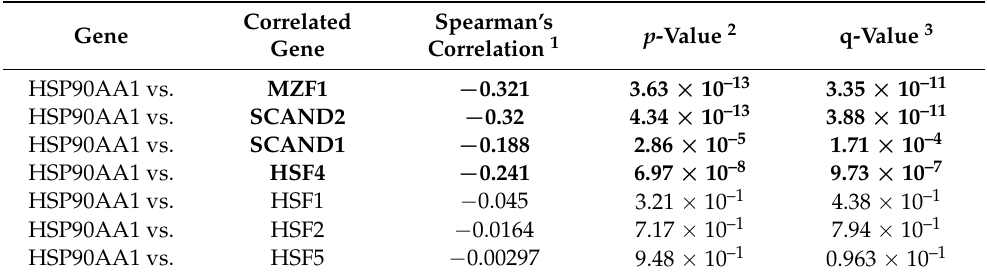
Table 5. The negative correlation of gene expression of HSP90AA1 vs. MZF1, SCANDs, and HSFs in prostate adenocarcinoma specimens. Correlated Spearman’s Gene p -Value 2 Gene Correlation 1 HSP90AA1 vs.